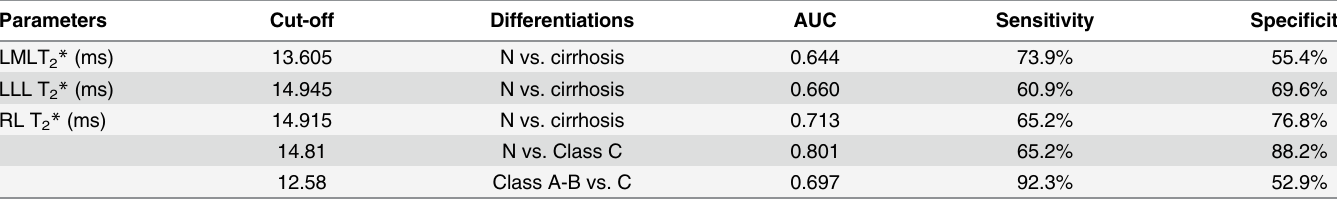
Table 3. Liver lobe based T2 * value in determining the presence and Child-Pugh class of cirrhosis.